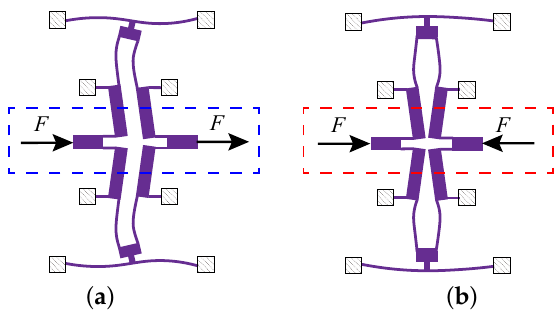
Figure 6. The two different mode shapes of the anchored diamond coupling beam in the in-phase mode ( a ) and anti-phase mode ( b ).